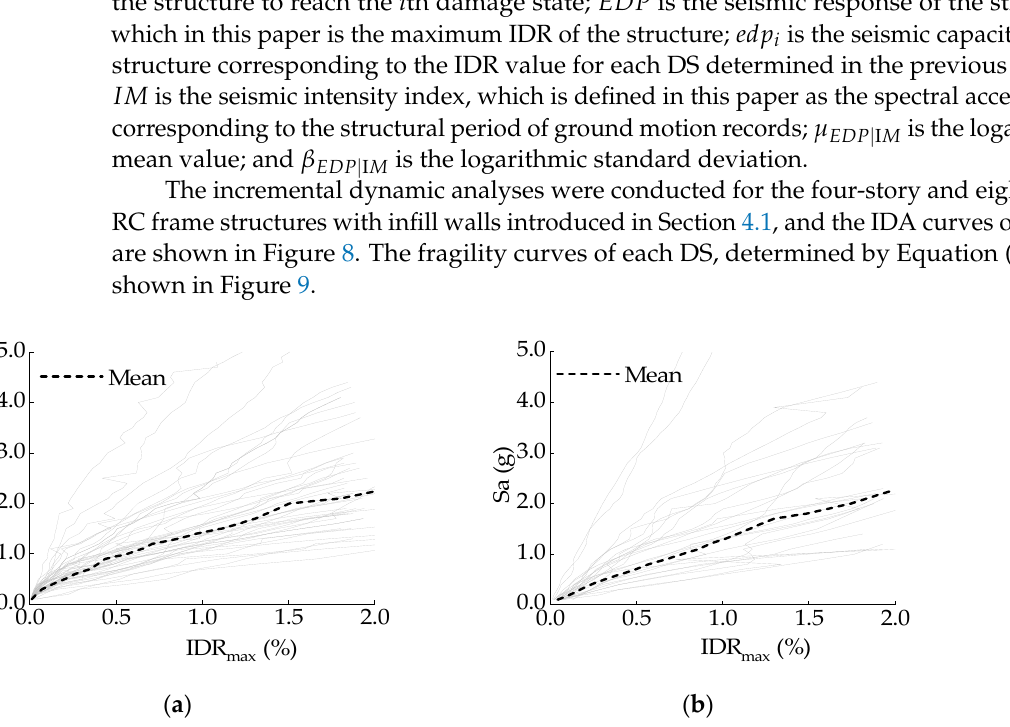
Figure 7. The acceleration spectra of the selected 44 ground motions.